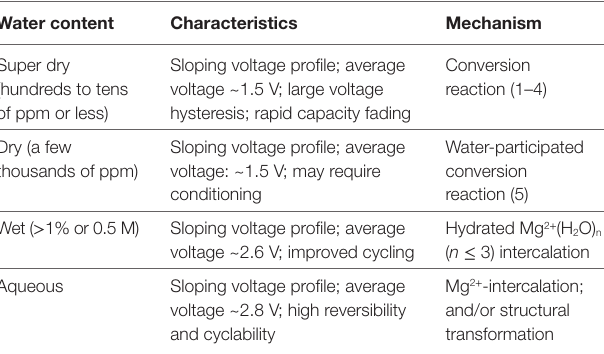
TABLe 2 | Summary of characteristics and reaction mechanism of MnO 2 cathode in different magnesium cell configurations. water